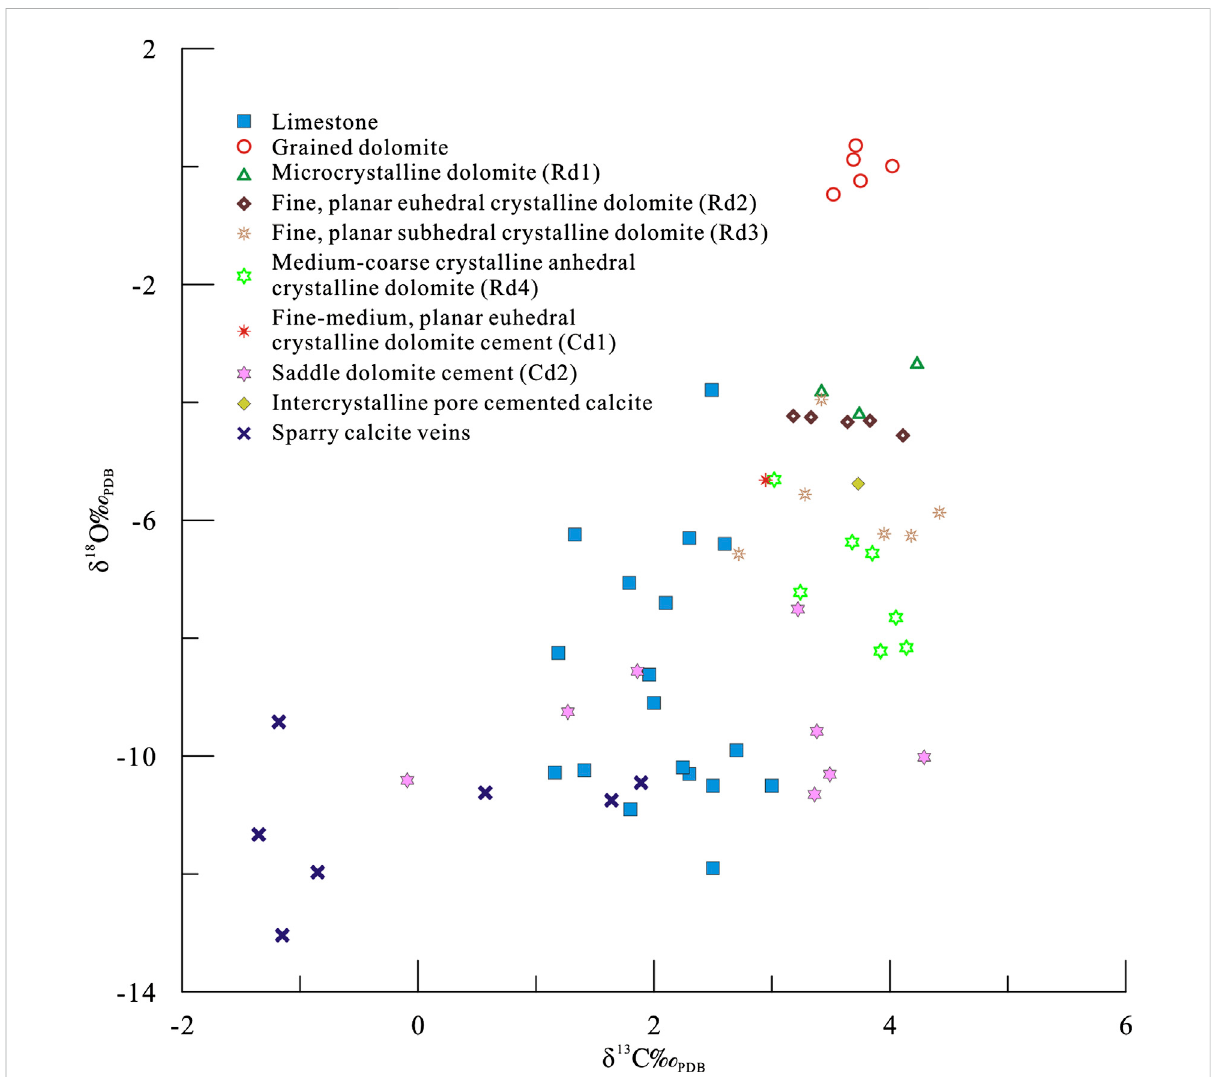
FIGURE 7 Cross-plot showing 87 Sr/ 86 Sr vs. δ 18 O for different carbonate rocks in the study